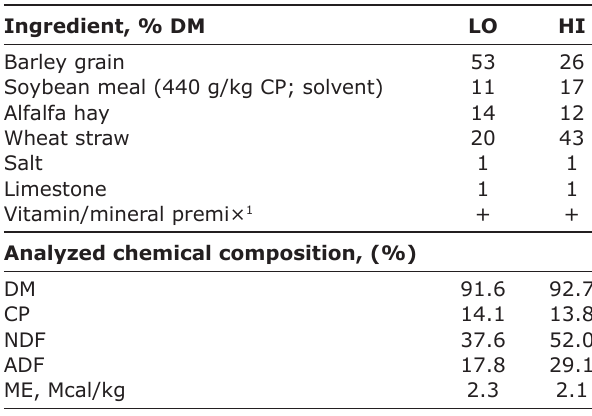
Table-1: Ingredients and chemical composition of the LO- and HI-fiber diets fed to Awassi female lambs. Ingredient, %